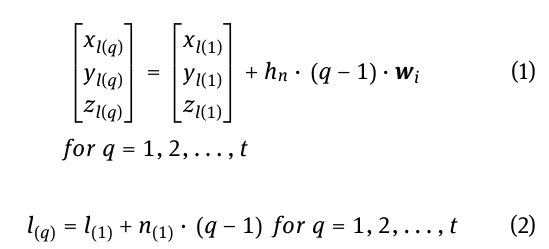
method of defining a vector normal to an element in the selected node l is explained in Figure 4a.